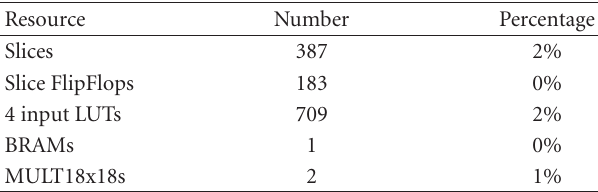
Table 1: Resource utilization.